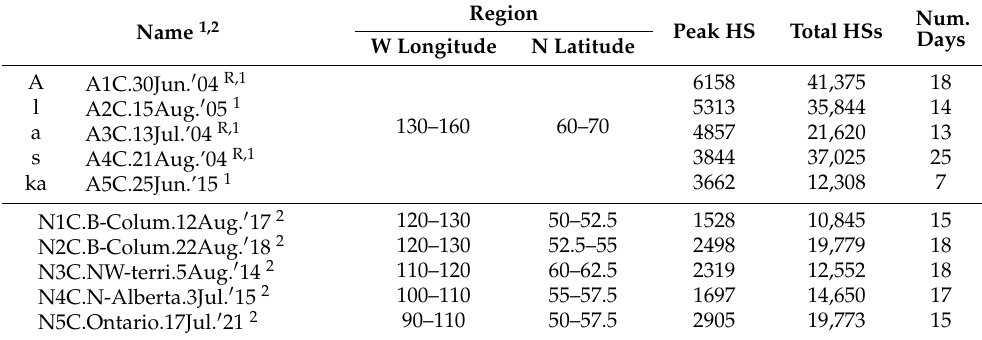
Table 2. Top five active fires in Alaska and other active fires in North